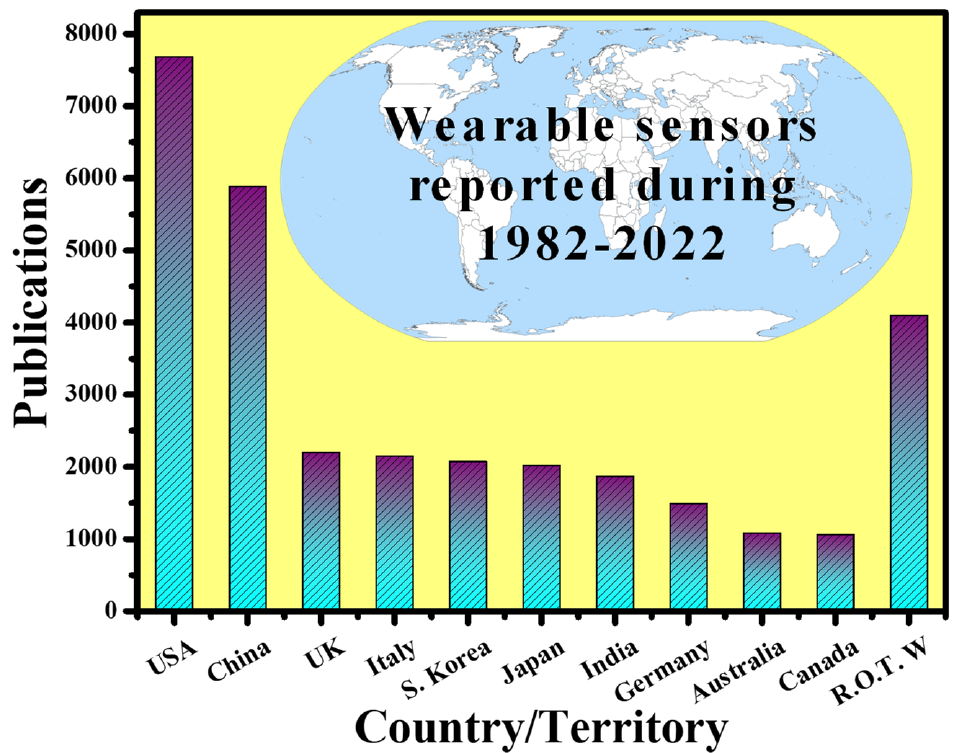
Figure 3. Scientific publications on “wearable sensors (electronics and photonics)” around the world. Results were collected on 19 November 2021.